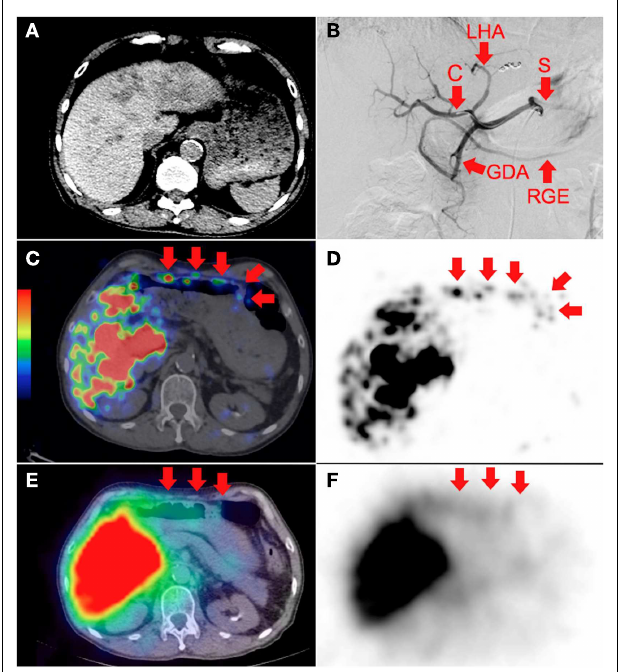
FIGURE 2 | (A) Multifocal hepatocellular carcinoma with predominantly left lobe disease seen on non-contrast-enhanced CT.The patient was recently treated with sorafenib, a multi-kinase inhibitor with anti-angiogenic properties. RE was performed in two injections via the left and right hepatic arteries. Prophylactic coil embolization of the gastroduodenal artery was not performed at the discretion of the interventional radiologist. (B) Digital subtraction angiogram immediately after completion of right hepatic artery RE with the catheter tip (“C”) in the right hepatic artery demonstrates significant vascular stasis and reflux of contrast into the left hepatic (“LHA”), proper hepatic, gastroduodenal (“GDA”), right gastroepiploic (“RGE”), common hepatic and splenic (“S”) arteries. (C,D) 90 Y PET/CT depicts in high resolution, non-target activity in a non-random distribution conforming to the anatomy of the lower anterior gastric wall. (E,F) 90 Y bremsstrahlung SPECT/CT shows concordant but subtle diffuse bremsstrahlung activity along the lower anterior gastric wall.The unexpected vascular stasis was attributed to reduced vascular capacitance due to the anti-angiogenic effects of recent sorafenib